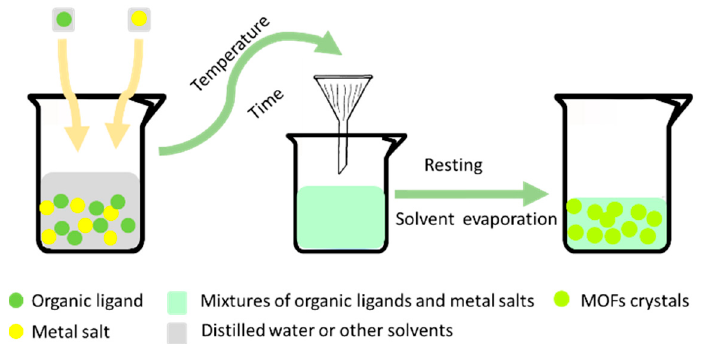
Figure 1. Schematic diagram for the synthesis of metal organic frameworks (MOFs) by the conventional solution method.